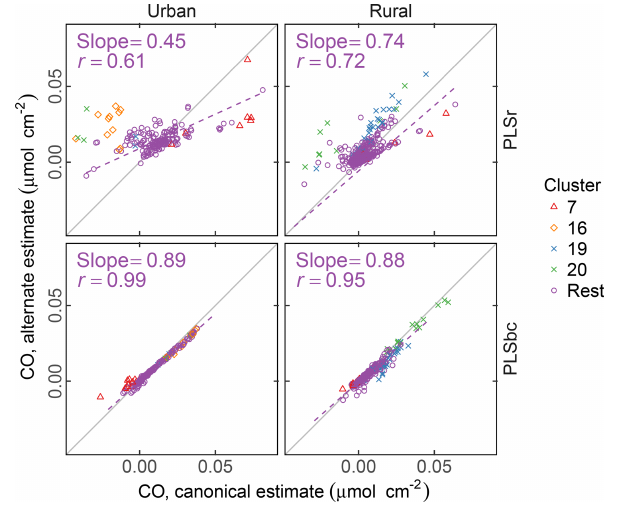
Figure 9. Comparison of estimated CO according to canonical cali- bration (as difference between molar abundance of cCOH and tCO), and alternate calibration (direct calibration to non-acid CO). PLSr refers to partial least square using raw spectra. PLSbc refers to par- tial least square using baseline-corrected